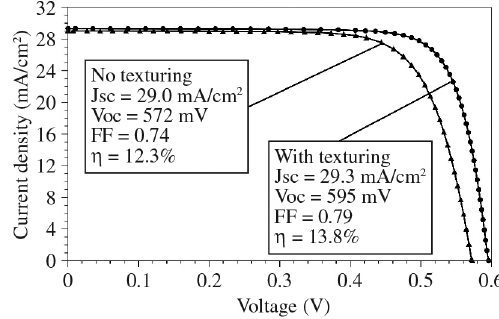
Figure 3. Electrical characteristics at standard conditions of the n + pn + solar cells with and without texturing etching in acidic